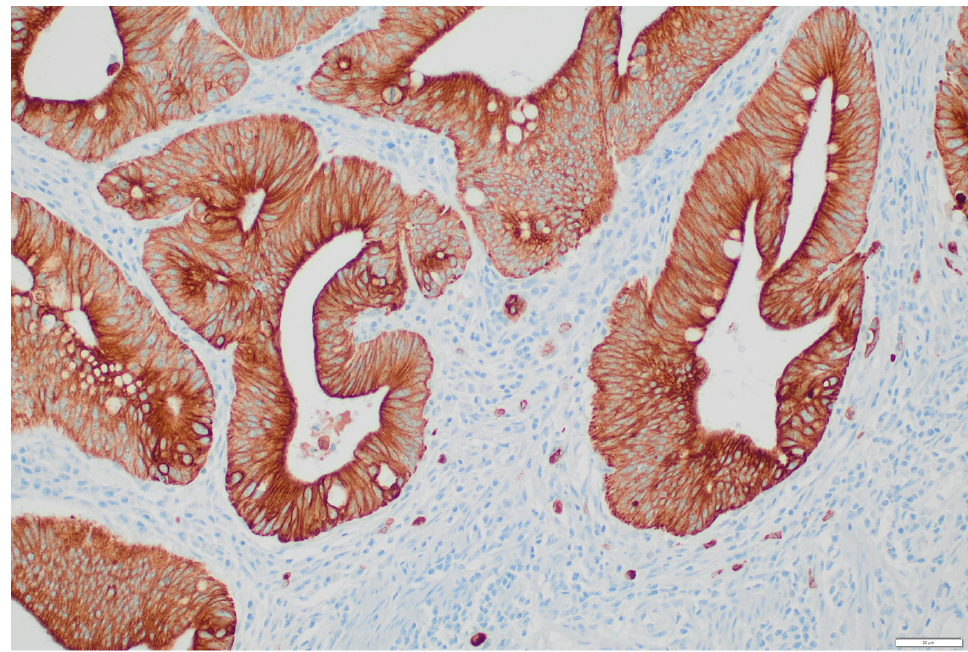
Figure 2. Tumour budding of an in situ colorectal carcinoma showing intermediate budding (Bd2) (CK CAM 5.2 ×200).